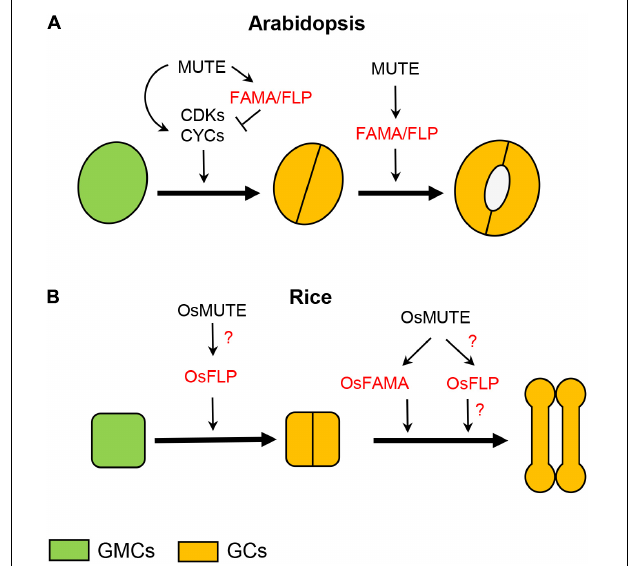
FIGURE 2 | Role of MUTE , FAMA , FLP , and their orthologs in rice during GMC progression and GC morphogenesis. (A) In the GMC of Arabidopsis, MUTE positively regulates cell-cycle genes, but also, immediately after, repressors of them, among them FAMA and FLP . This makes possible that the GMC undergoes a single cell division. MUTE, by promoting FAMA and FLP expression, in addition to halt proliferative GMC divisions, controls GC differentiation. (B) In rice, OsMUTE guides GMC face by correctly orientating its cell division plane, perhaps by positively regulating OsFLP . OsMUTE also controls GC morphogenesis by promoting OsFAMA expression. OsMUTE may also regulate OsFLP to guide GC morphogenesis. It is not known what makes it possible for GMCs to undergo a single cell division. GC, guard cell; GMC, guard mother